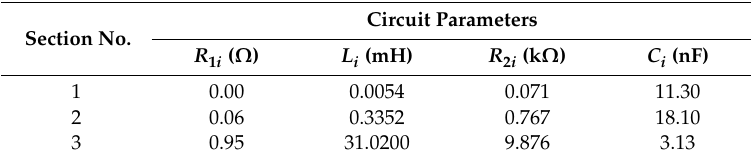
Table 6. Circuit parameters determined by the proposed approach.